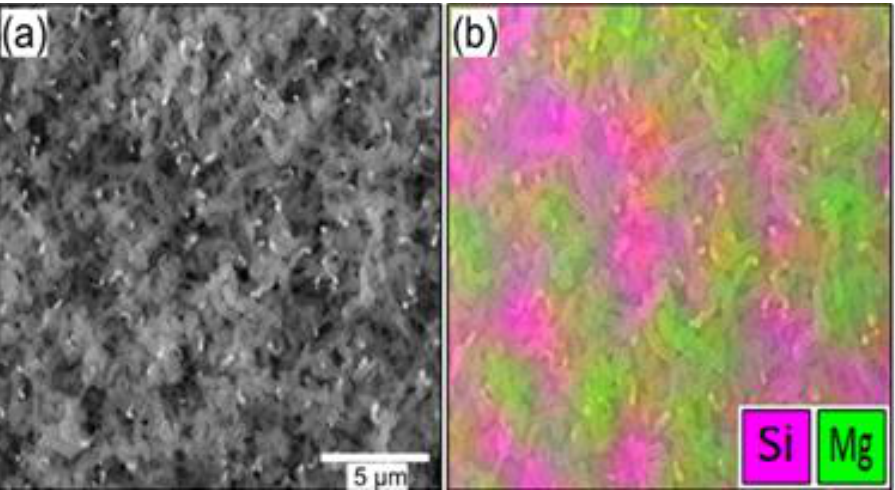
Figure 2. ( a ) An SEM micrograph of Mg-coated NS and ( b ) the corresponding EDS map of Mg and Si.